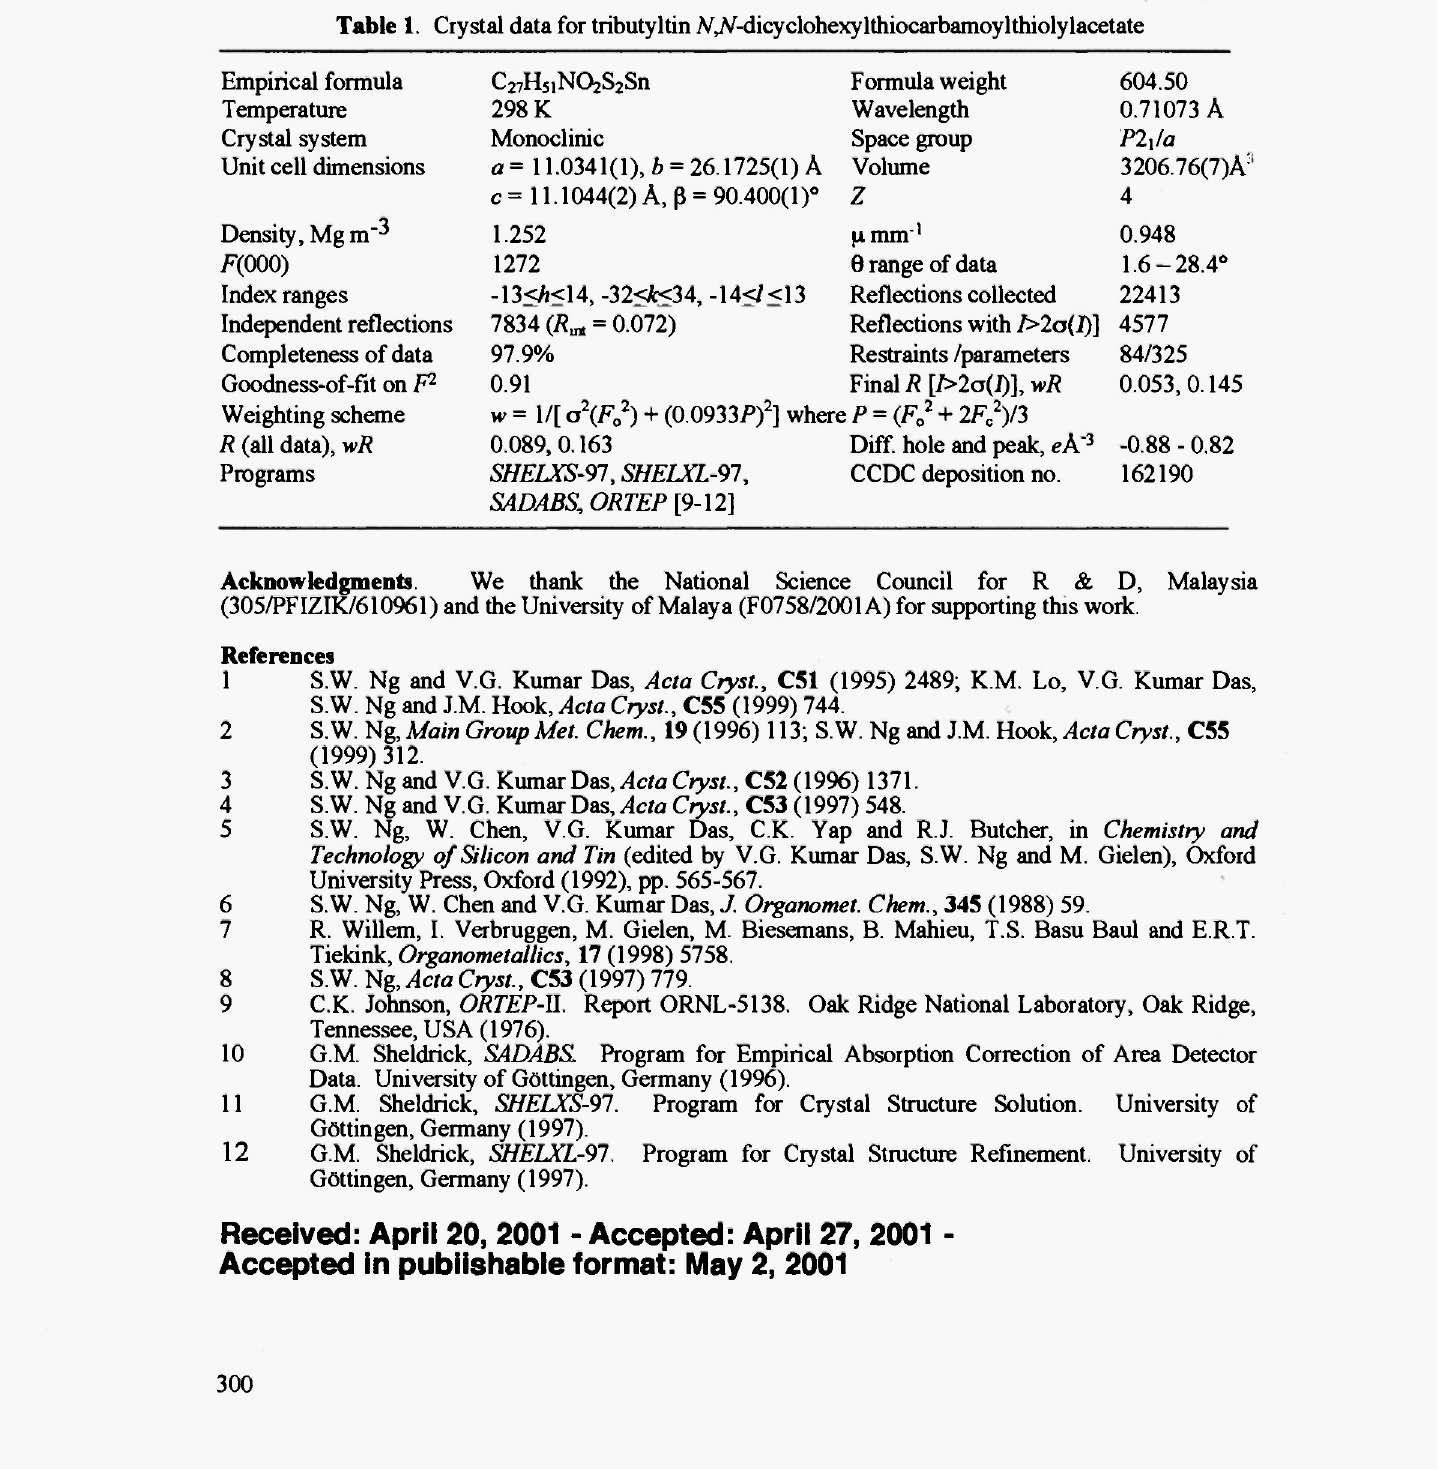
Table 1. Crystal data for tributyltin